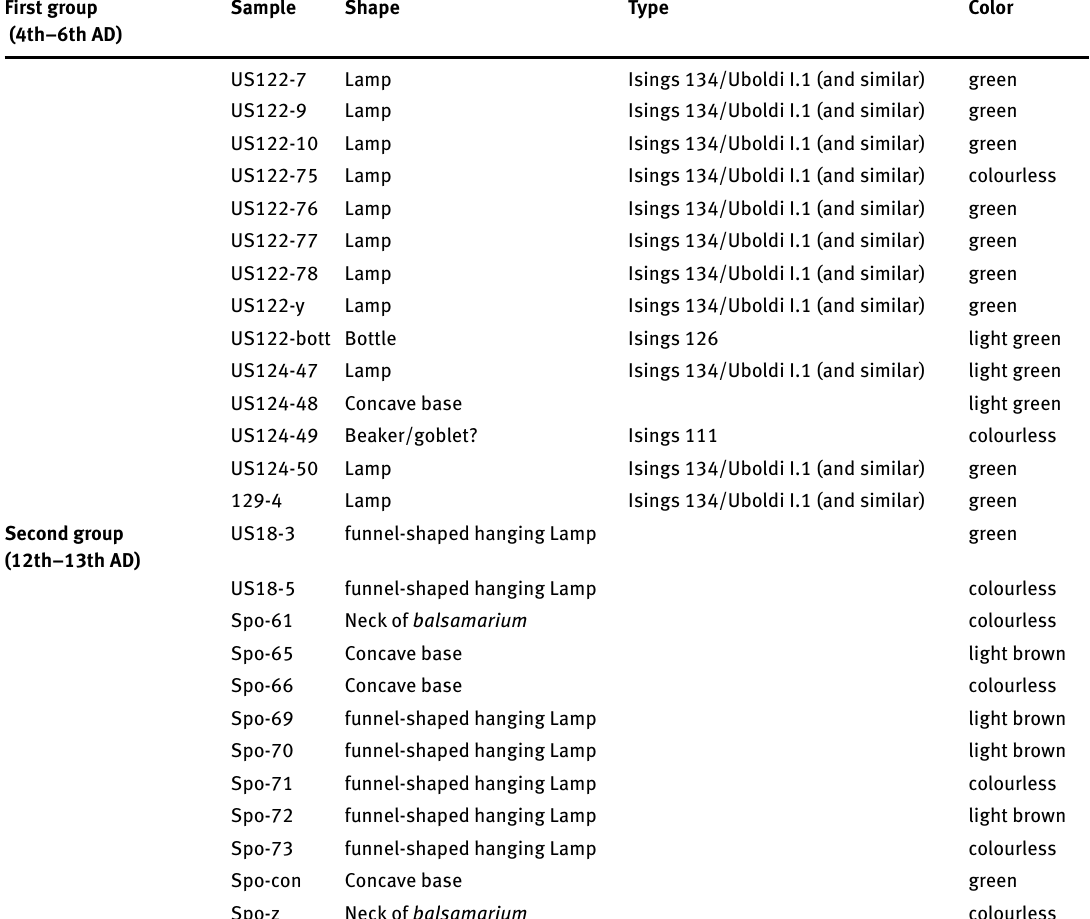
Table 1: List of the examined vitreous finds collected in the Cosenza Cathedral. First